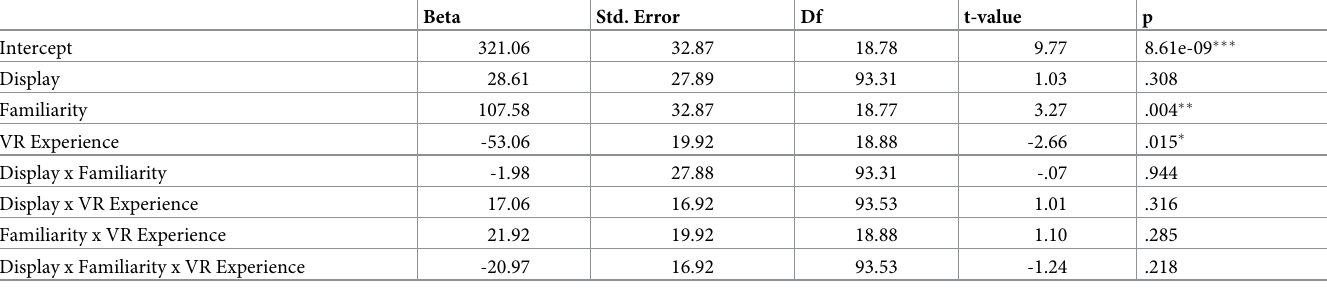
Table 4. Full model results for response